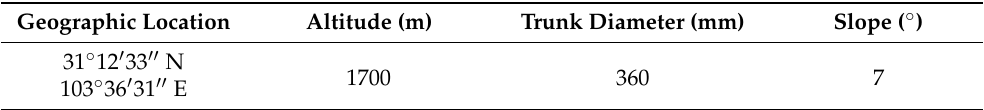
Table 1. Location and characteristics of Chinese fir.